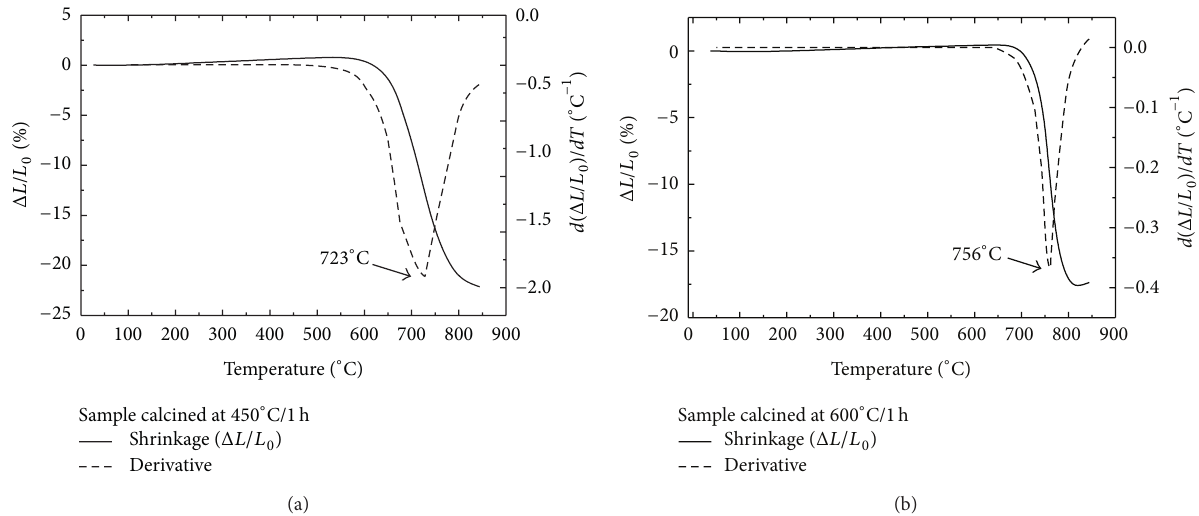
Figure 4: Dilatometric analysis of the samples calcined at (a) 450 ∘ C/1h and (b) 600 ∘ C/1h. Closed symbols represent the shrinkage and open symbols represent the shrinkage